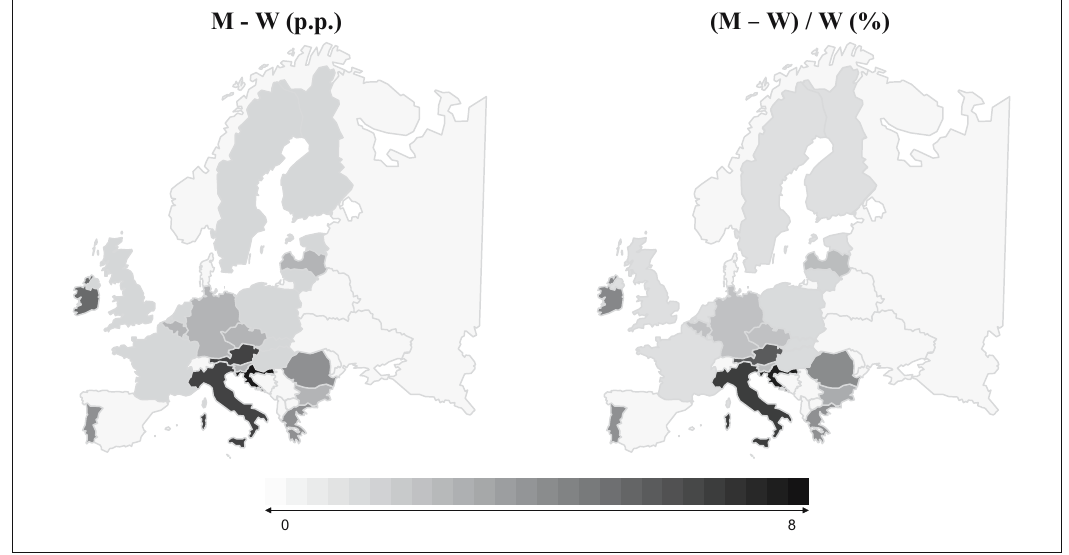
Figure 6: Digital gender gap in the ICT - USE indicator in the EU - 28, 2019. Note: Cyprus has the same color than Denmark. Source: Own elaboration based on the Digital Economy & Society Database ( Eurostat ) and using Clearly and Simply (